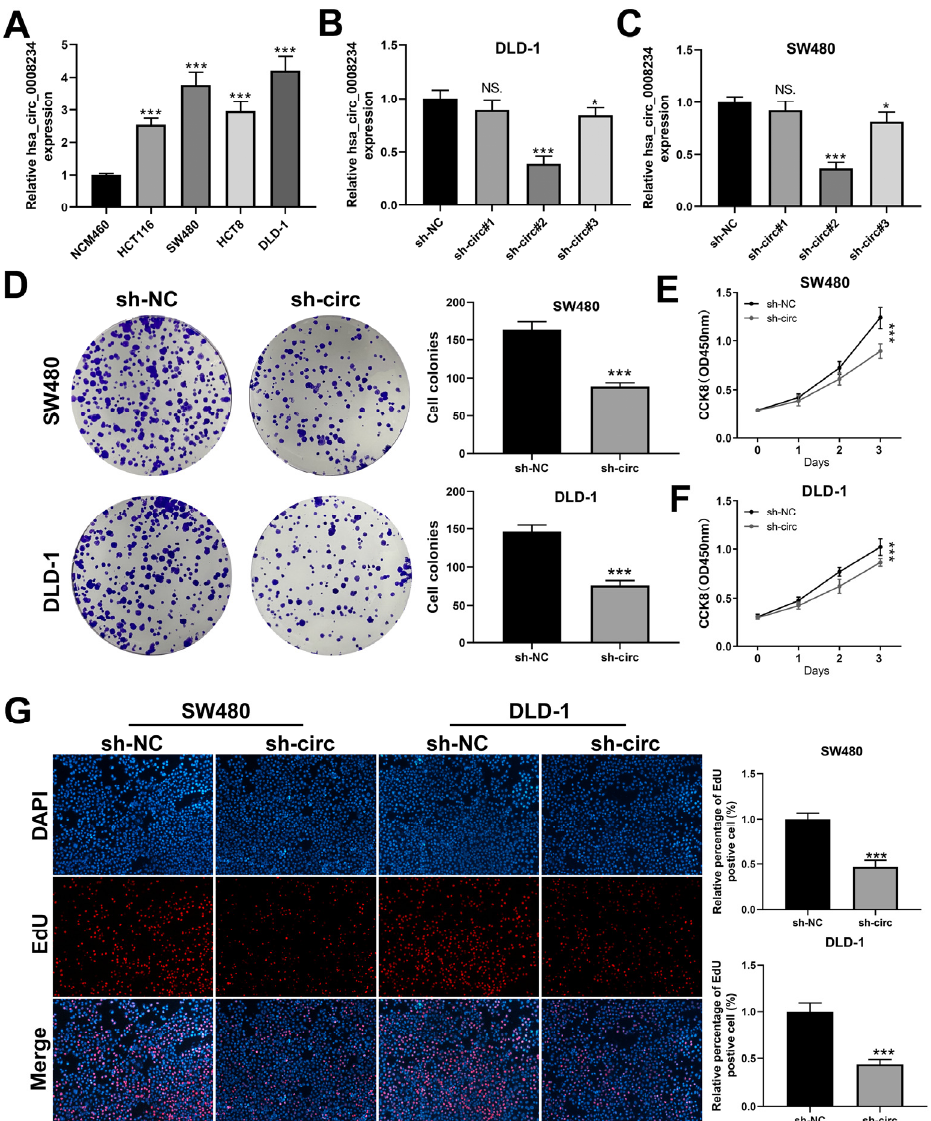
Figure 2. Hsa_circ_0008234 promotes colon cancer proliferation. Notes: ( A ) Hsa_circ_0008234 was increased in colon cancer cells, *** = p < 0.001; ( B , C ) qRT-PCR assay was conducted to assess the knockdown efficiency of hsa_circ_0008234, NS. = p > 0.05, * = p < 0.05, *** = p < 0.001; ( D ) Colony formation assay between hsa_circ_0008234 knockdown and control cells, *** p < 0.001; ( E , F ) CCK8 assay between hsa_circ_0008234 knockdown and control cells, *** = p < 0.001; and ( G ) EdU assay between hsa_circ_0008234 knockdown and control cells, *** = p < 0.001.